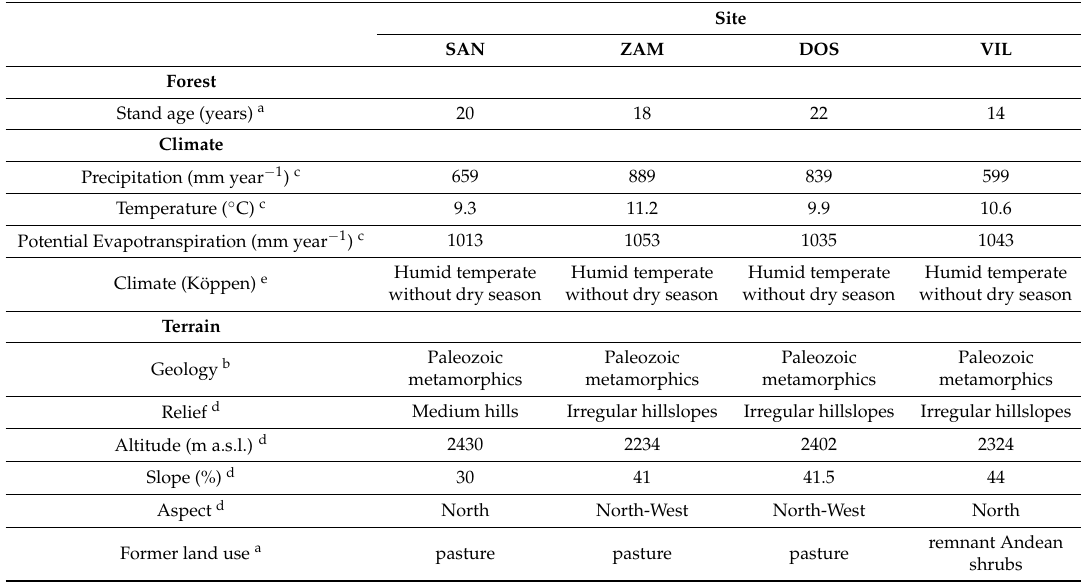
Table 1. Description of the pine plantation ( Pinus patula ) sites (DOS: Dos Puentes, SAN: Santiago, VIL: Villonaco, ZAM: Zamora-Huayco) included in this study.